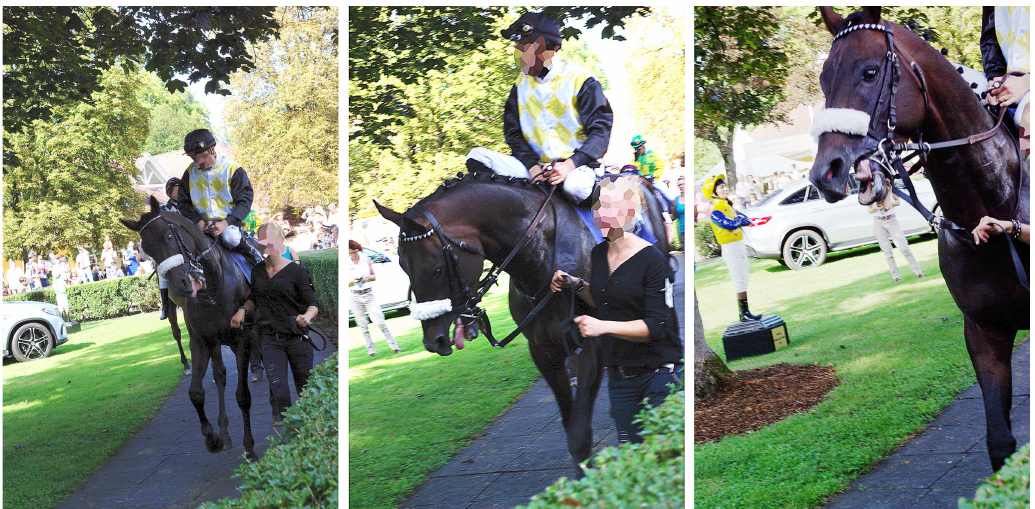
Figure A1. Images 1–3 of eight images of a thoroughbred with a tongue-tie taken on race day while the horse was led past the photographer / researcher in the mounting